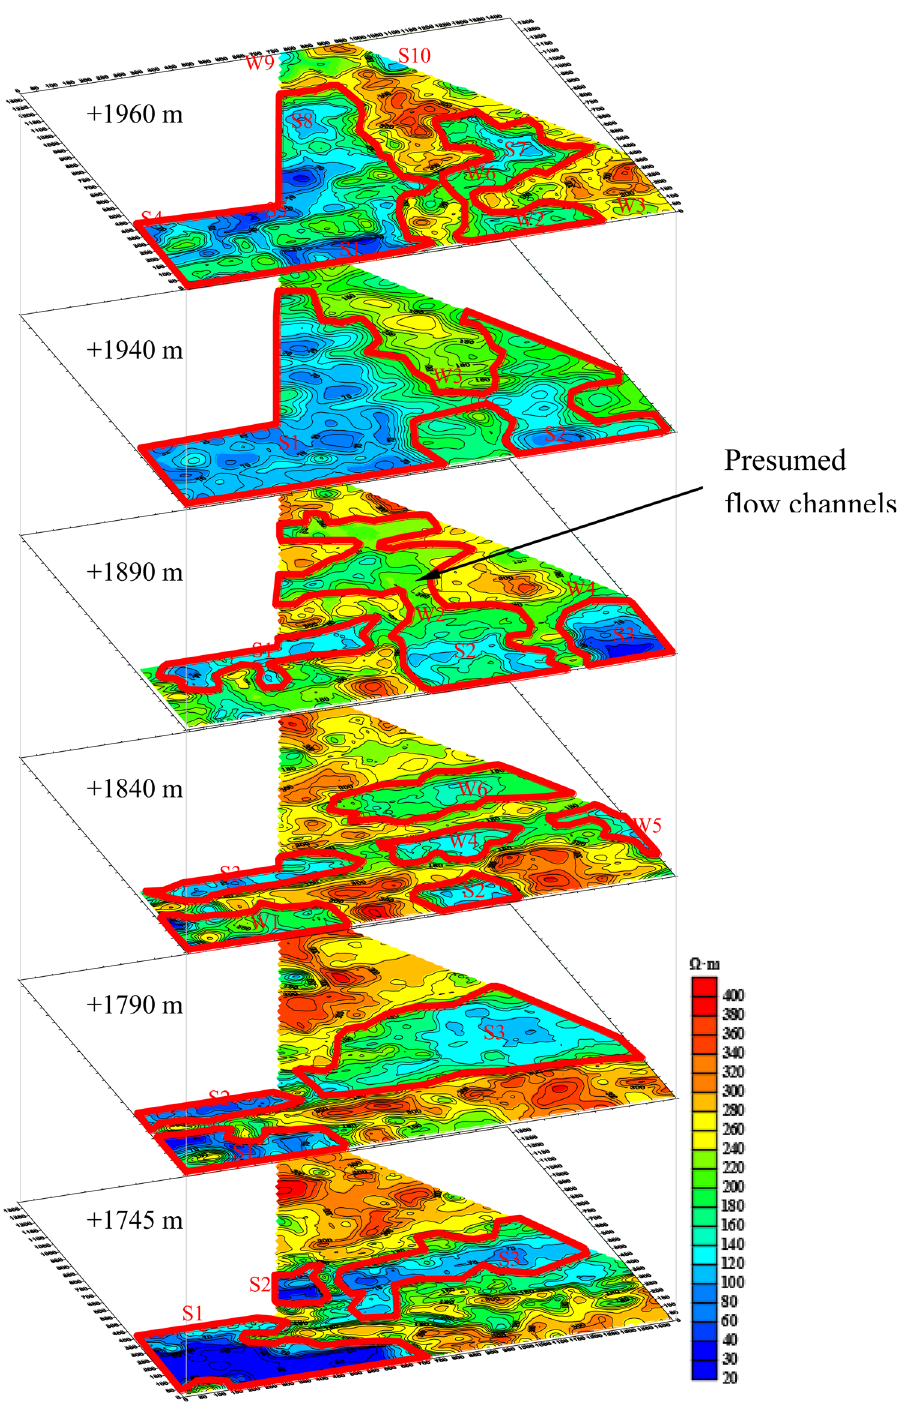
Figure 18. The resistivity profile of the TEM of horizontal slices ( a ) + 1960 m, ( b ) + 1940 m, ( c ) + 1890 m, ( d ) + 1840 m, ( e ) + 1790 m, ( f ) + 1745